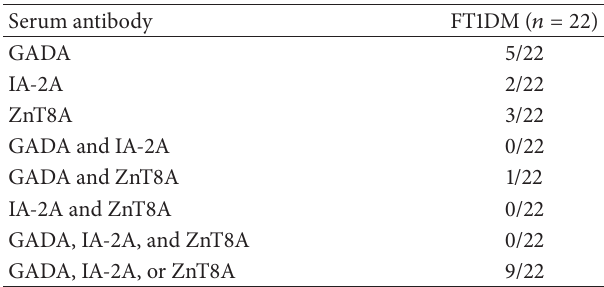
Table 2: Distribution of GADA, IA-2A, and ZnT8A in 22 Chinese FT1D patients.